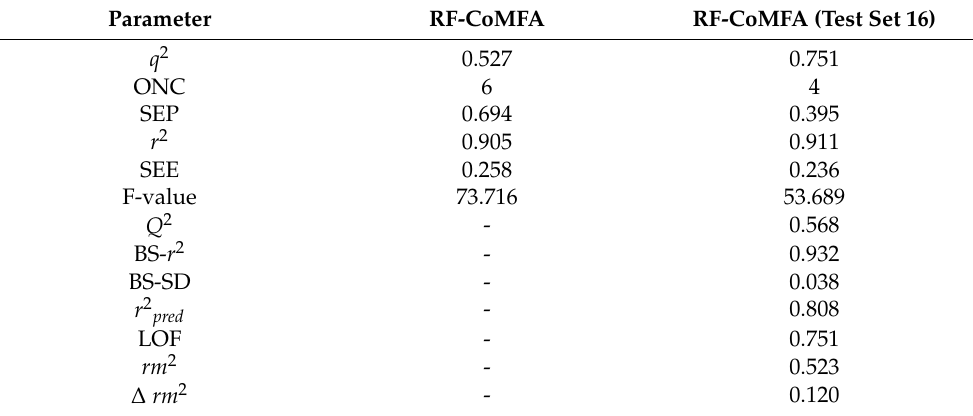
Table 1. Detailed statistical values of the selected RF-CoMFA model.